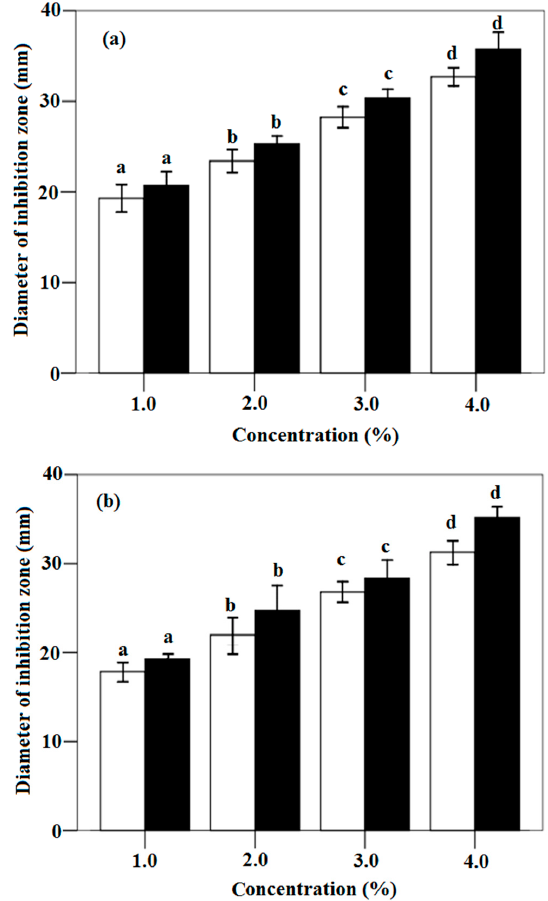
Figure 5. The antimicrobial activity of trans-cinnamaldehydes and cinnamon oil against: P. citrinum ( a ); and A. flavus ( b ). □ : trans-cinnamaldehydes; ■ : cinnamon oil; mean bars with different letters (a–d) differ significantly at p < 0.05.